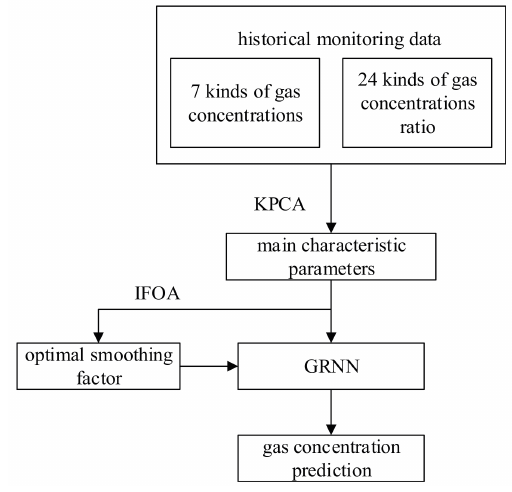
Figure 2. Flow chart of transformer oil dissolved gas concentration